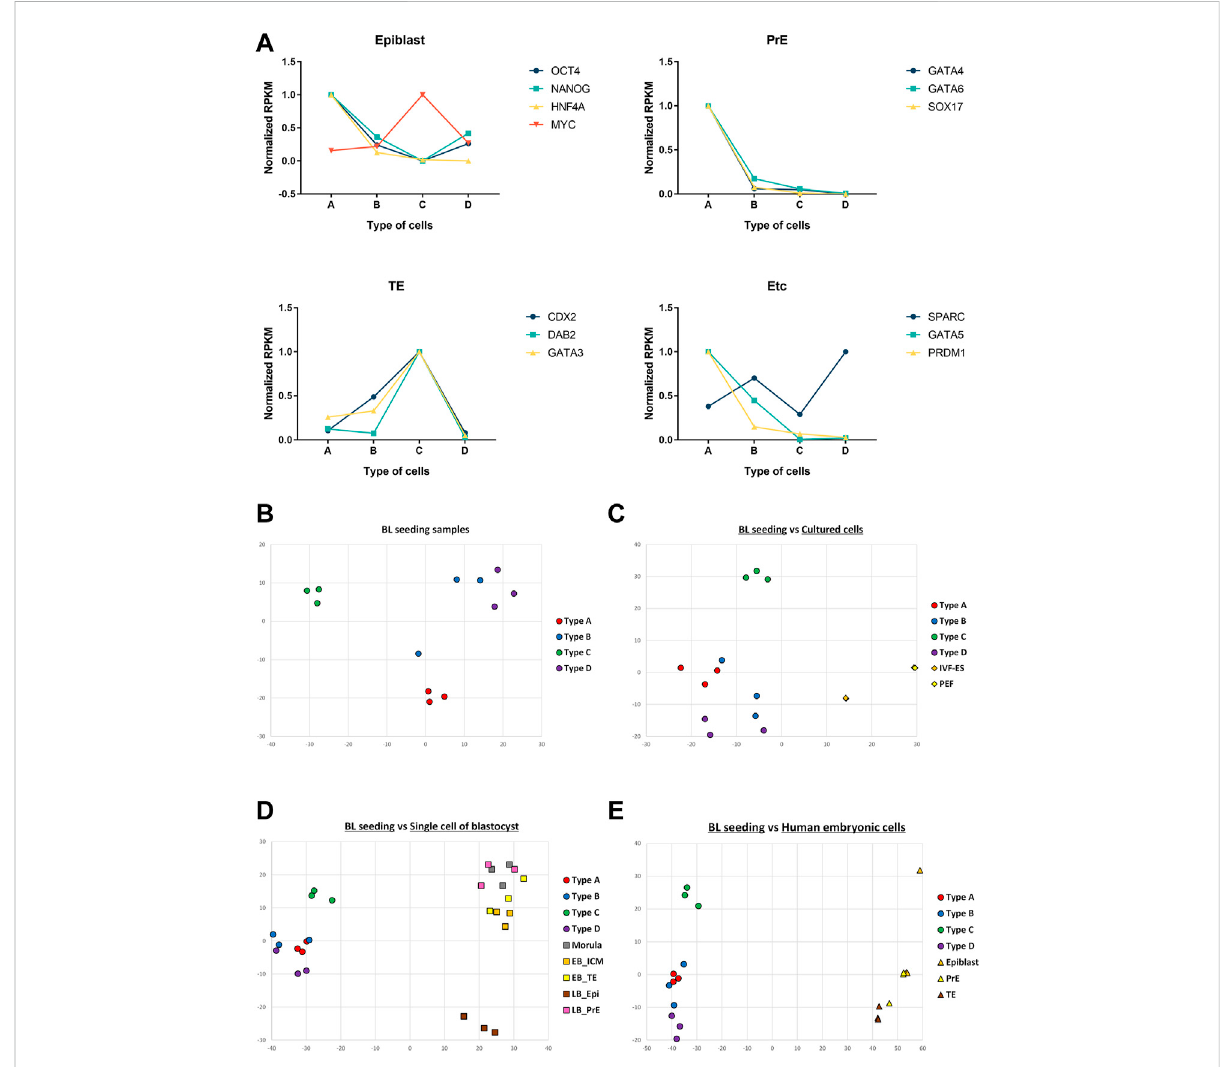
FIGURE 6 RNA-seq data of the four types of cells and comparison of RNA-seq results. (A) Normalized RPKM values of marker genes. Epiblast: OCT4, NANOG, HNF4A, MYC. Primitive endoderm: GATA4, GATA6, SOX17. Trophectoderm: CDX2, DAB2, GATA3. XEN; SPARC. Mesoderm: GATA5, Germ cell: PRDM1. Multidimensional scaling of samples. (B) Multidimensional scaling of 12 samples from the four cell types. (C) Comparison of 12 samples with cultured porcine cells. (D) Comparison of 12 samples with single-cell RNA-seq results from porcine embryos. (E) Comparison of 12 samples with single-cell RNA-seq results from human embryos. (BL, blastocysts; IVF-ES, embryonic stem cells established from in vitro fertilized embryos; PEF, porcine embryonic fi broblasts; EB, early blastocysts; LB, late blastocysts; ICM, inner cell mass; TE, trophectoderm; Epi, epiblasts; PrE, primitive